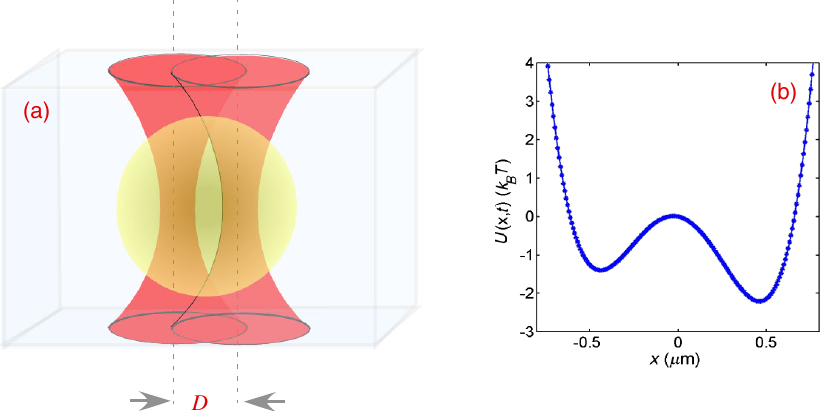
FIG. 4. (a) Drawing of the polystyrene particle trapped by two laser beams whose axis distance is about the radius of the bead. (b) Potential felt by the bead trapped by the two laser beams. The barrier height between the two wells is about 2 k